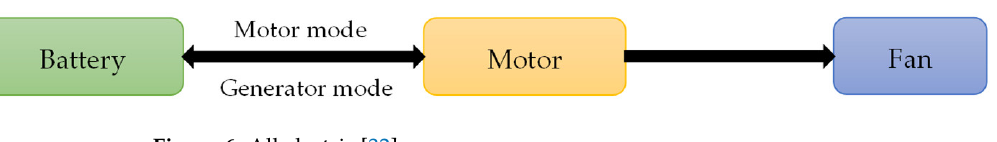
Figure 6. All electric